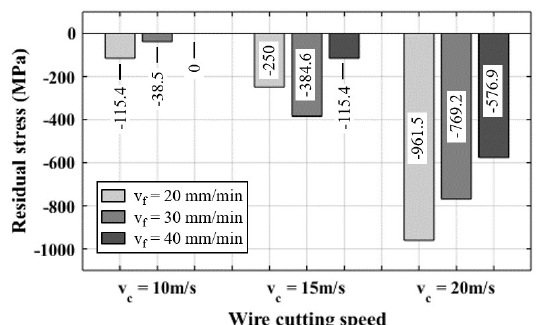
Figure 10. Estimated residual